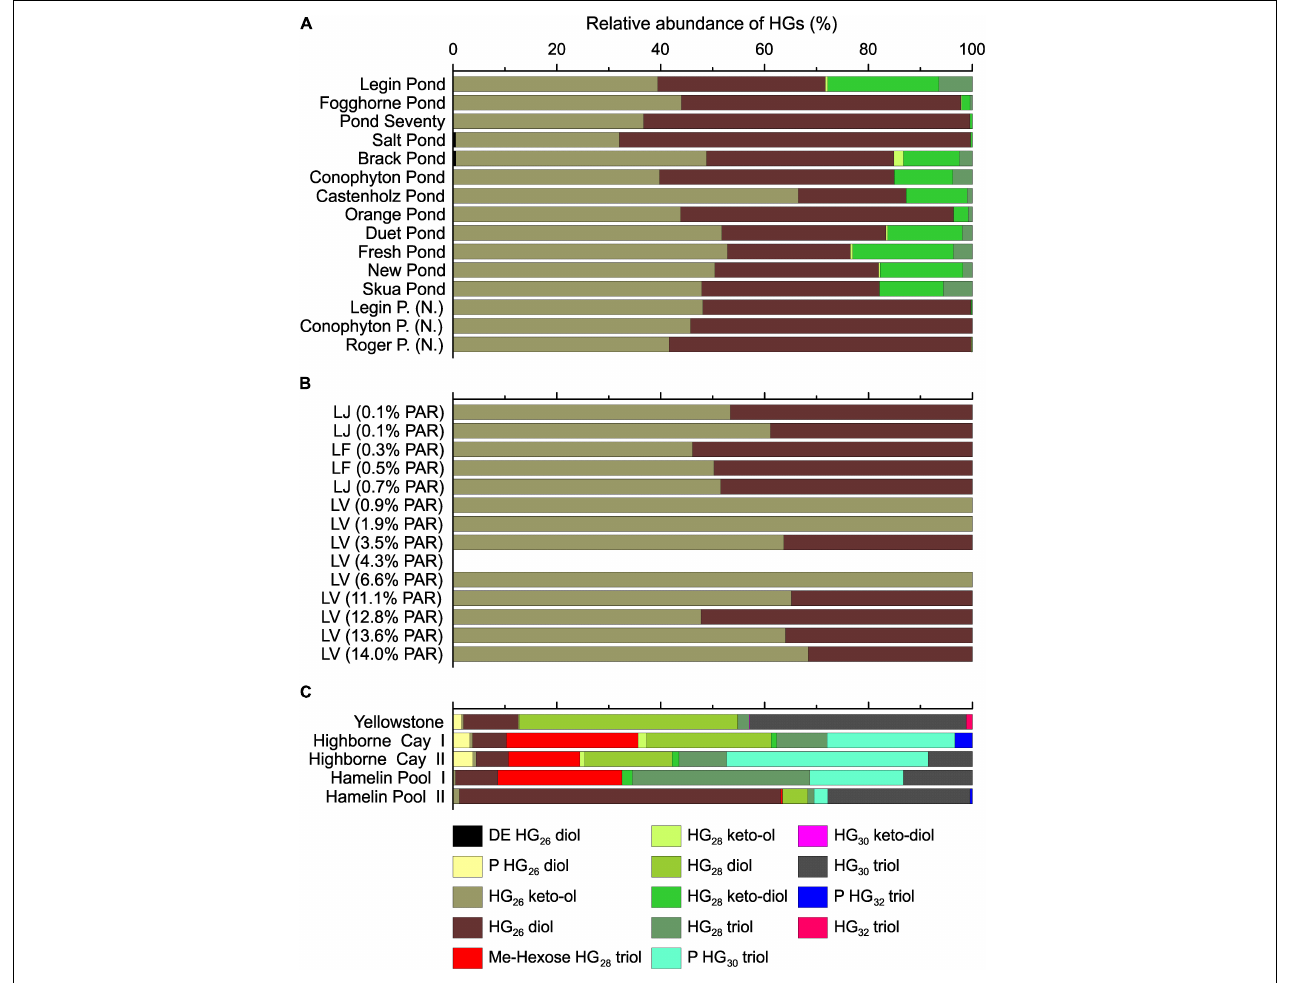
FIGURE 6 | Heterocyte glycolipid distribution in the meltwater ponds from the McMurdo Ice Shelf (A) . Samples with (N.) indicate ‘Nostoc spheres,’ which were collected in three different meltwater ponds. Panel (B) shows the results from the three different Antarctic lakes: Lake Joyce (LJ), Lake Fryxell (LF) and Lake Vanda (LV). The brackets show the percentage of photosynthetically active radiation (PAR) that reached the microbial mats. The PAR was adopted from previous studies (Jungblut et al., 2016; Mackey et al., 2017b, 2018; Matys et al., 2019). HGs in LV 4.3% PAR were below detection limit. Panel (C) shows the relative abundance of HGs in the microbial mats from the Yellowstone National Park (United States), Highborne Cay (Bahamas), and Hamelin Pool (Australia). DE, deoxyhexose; P, pentose; Me-hexose, methyl-hexose.